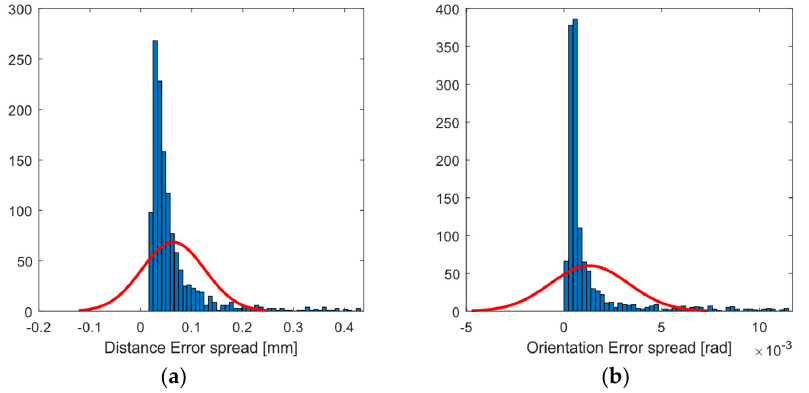
Figure 11. Histogram plot of the 97th percentile for error spread in ( a ) position (mm); and ( b ) orientation (rad). The red line represents a normal distribution as a comparison.